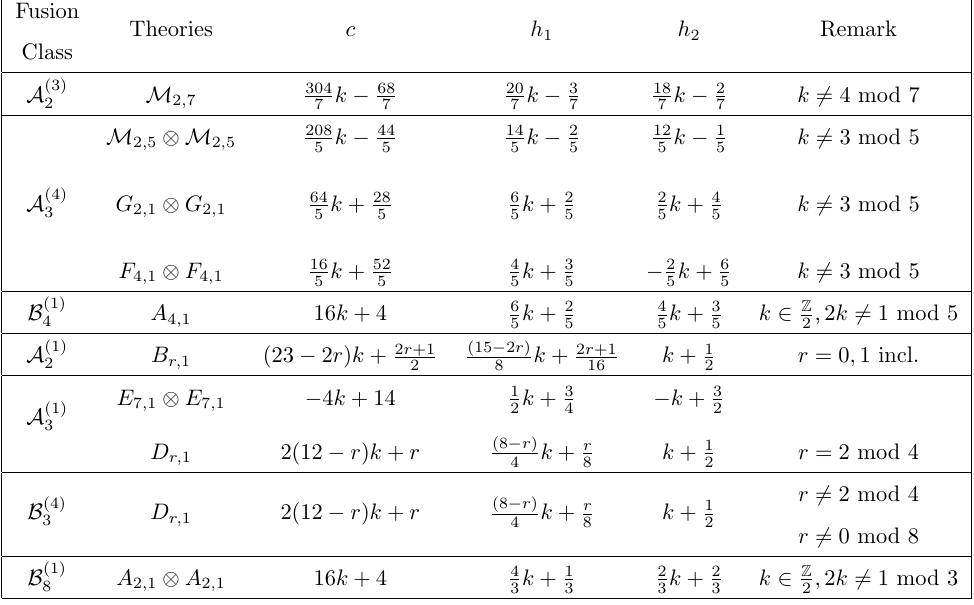
Table 2 . In(cid:12)nitely many sets of quasi-character families for each fusion class. Here n; r 2 Z subject to the restrictions